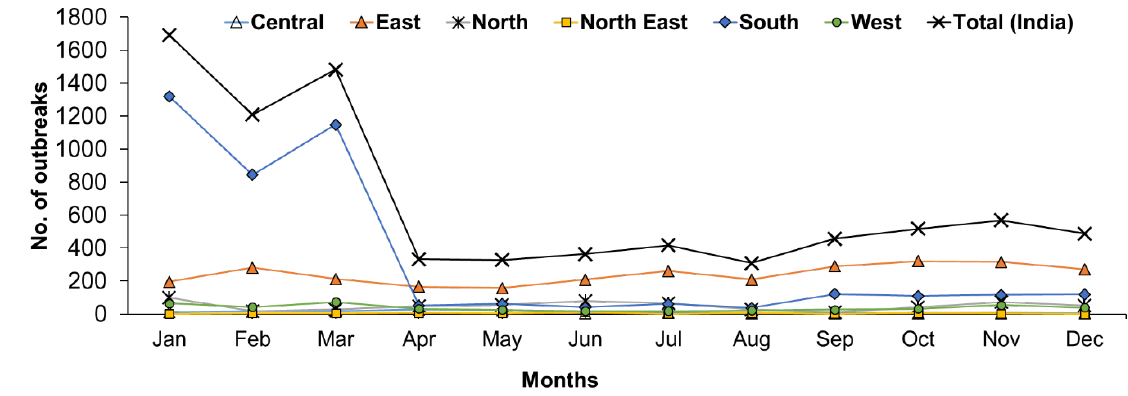
Figure 7. Month-wise analysis of cumulative PPR outbreaks in different zones in India (1995–2019). The outbreaks were predominantly observed between December to April in the South zone, during October & November in the East zone; April & May months in the Central zone; in June in the North-East zone; from January to March in the Western zone and between November and January in the North Zone.